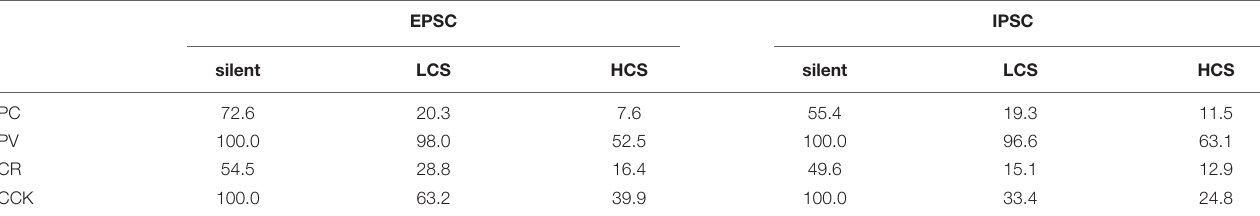
TABLE 3 | Percentage of PSCs detected with 10 pA